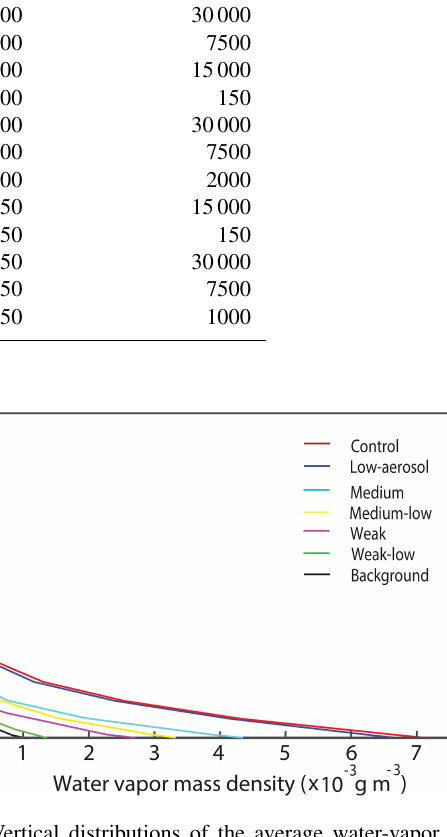
Figure 5. Vertical distributions of the average water-vapor mass density at altitudes above 13km and over the simulation period be- tween 17:00GMT on 5 August and 12:00GMT on 6 August. Col- ored lines represent the average values over cloudy grid columns (non-zero sum of LWP and IWP). The black line represents those values over non-cloudy columns (zero sum of LWP and IWP) in the control